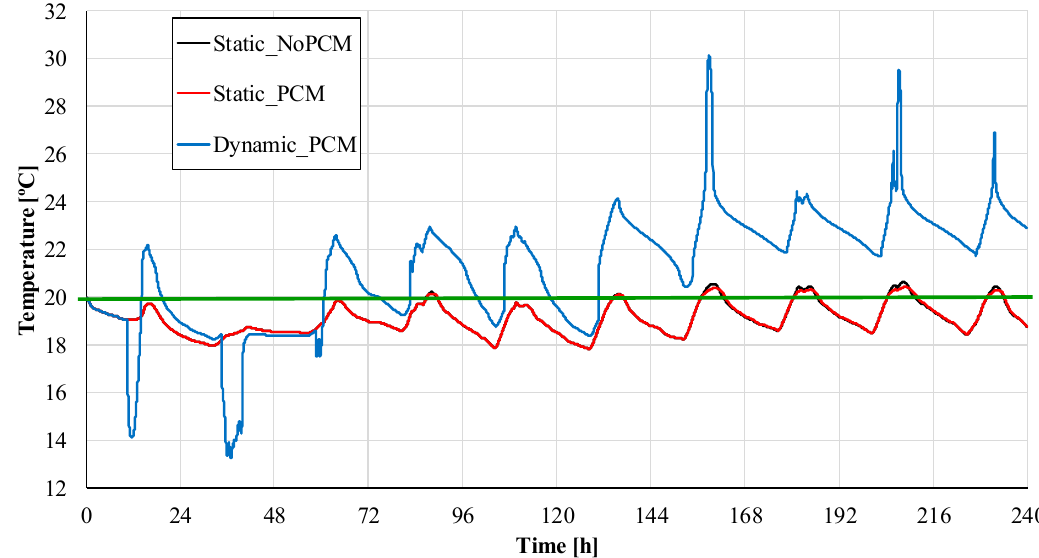
Figure 5. Evolution of polymeric layer temperature when implemented in the ASHRAE (Wall 2) envelope.